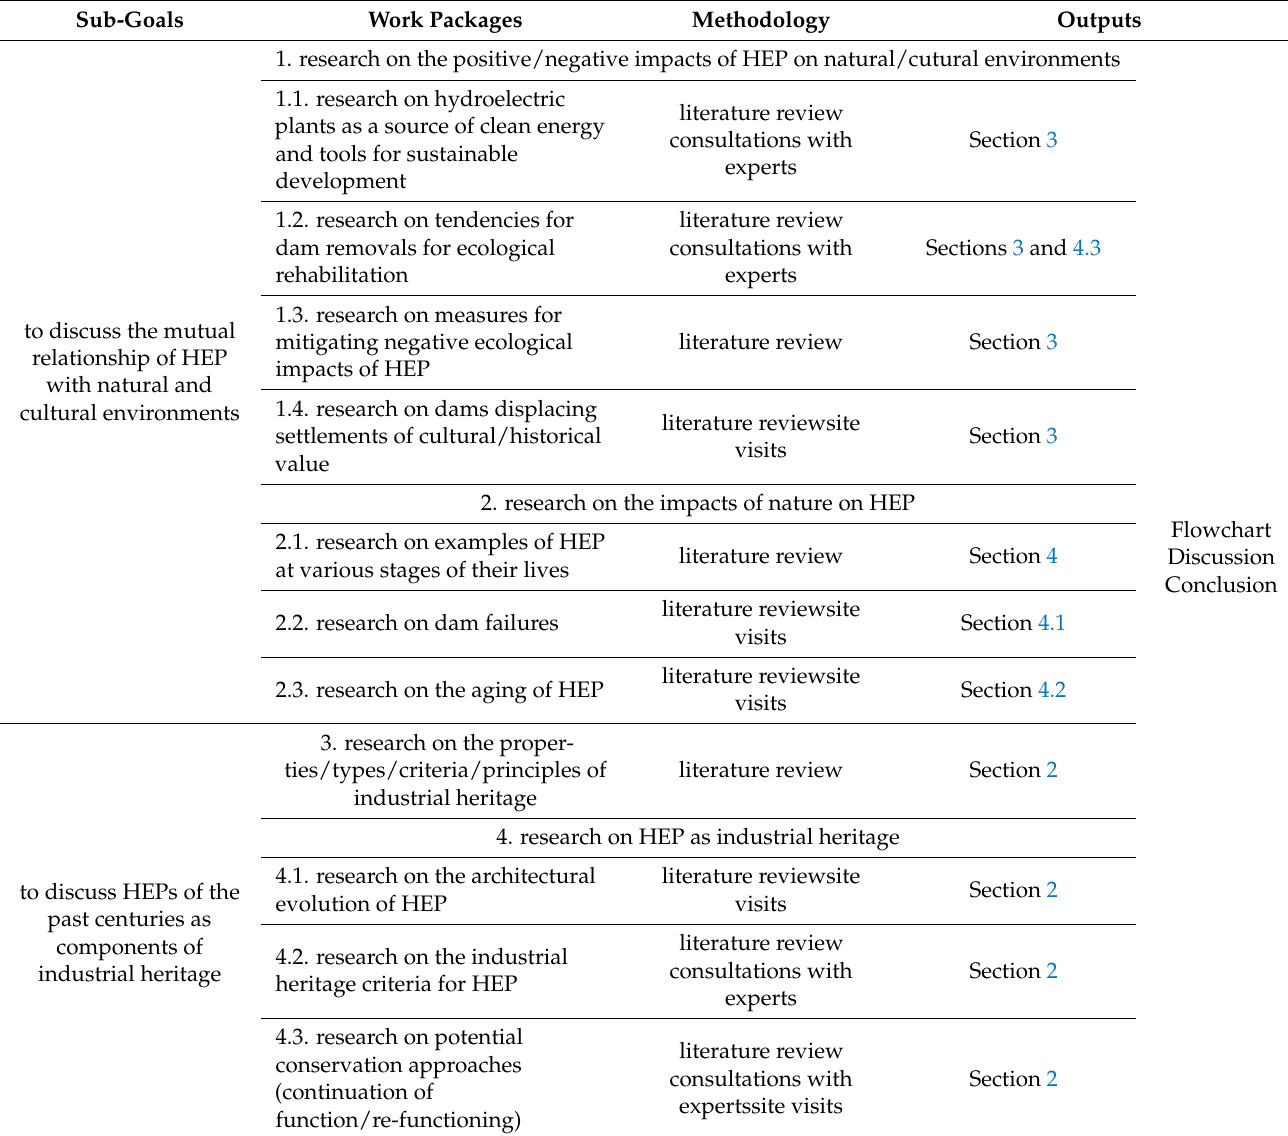
Table 1. Objectives, methodology, and outputs of the